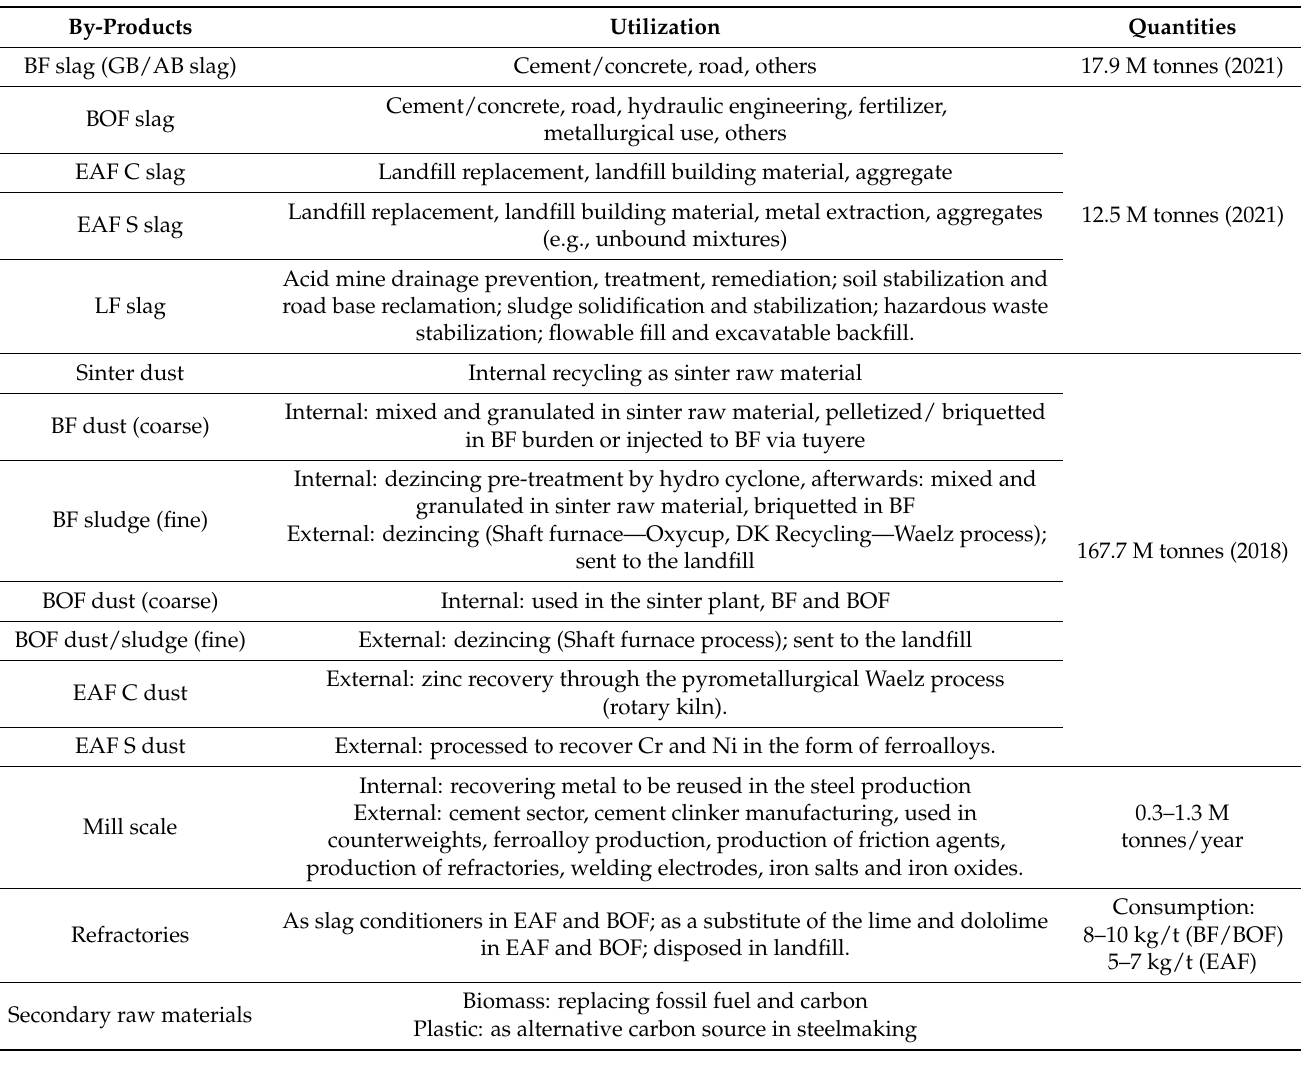
Table 1. By-products streams and their uses.